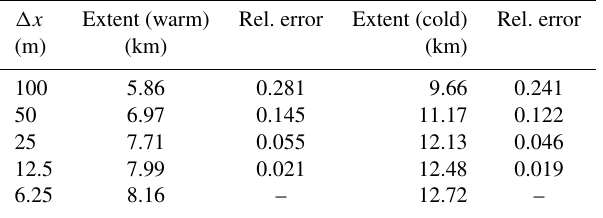
Table A1. Convergence test results for steady-state glacier extent corresponding to c = 0 .